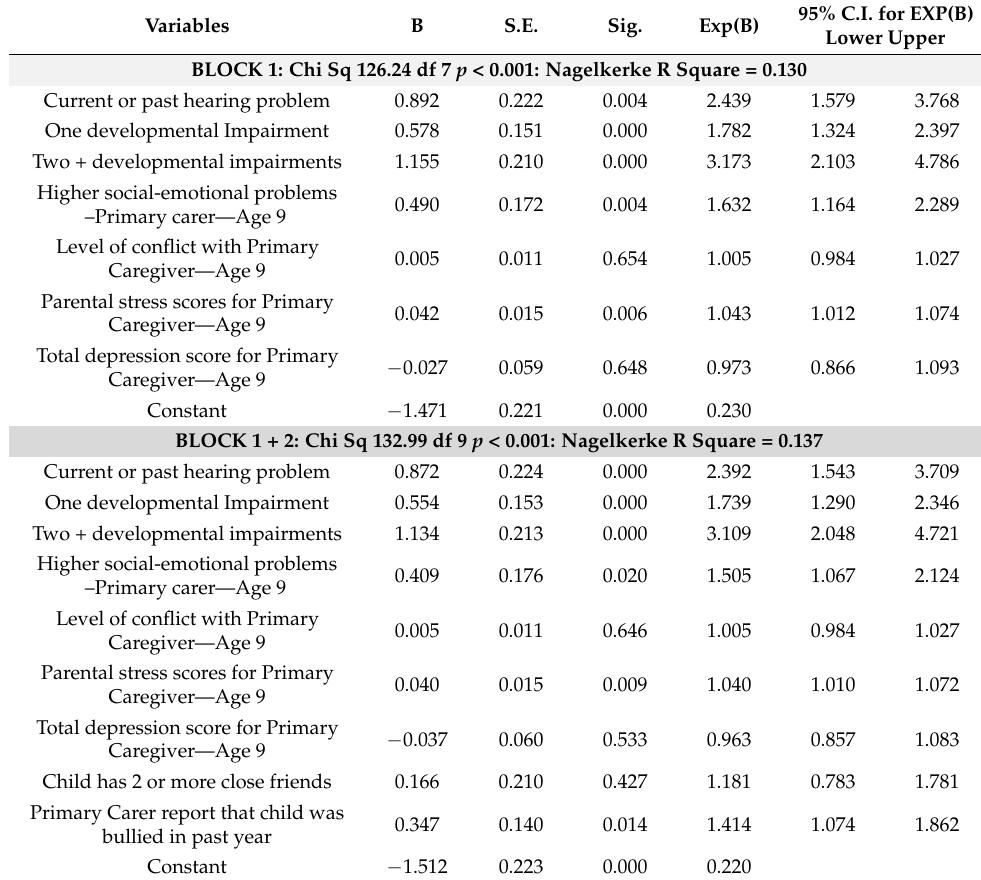
Table 4. The results of the step-wise Binary Logistic Regression contrasting children with improved speech and language difficulties and those with continuing